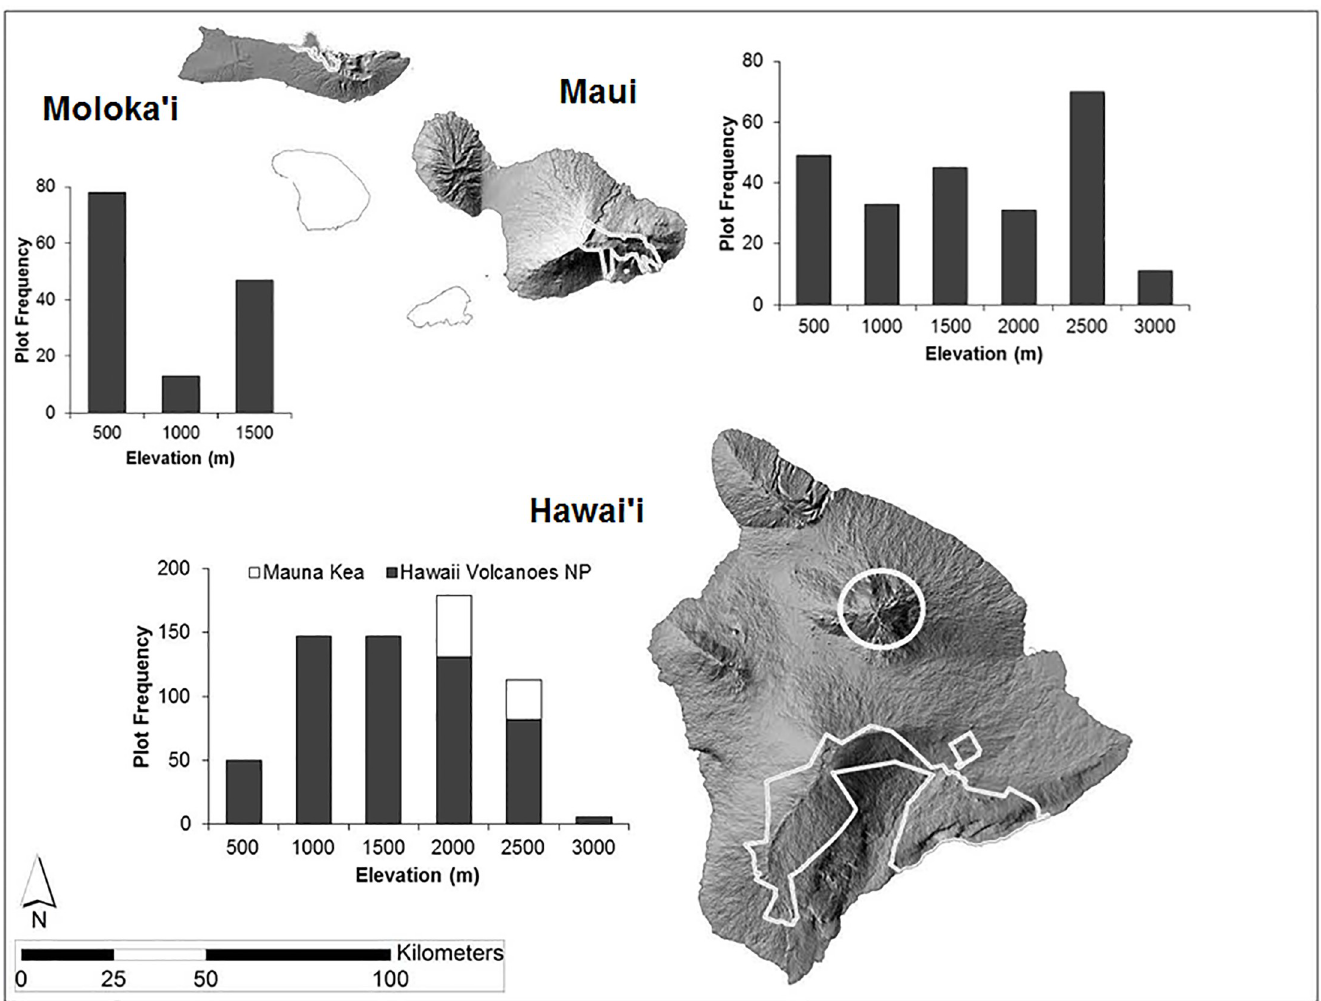
Fig 1. Hawaiian Islands on which plant species co-occurrence samples (1017 plots) were collected between 2004 and 2012. Plots range from sea level to 3000 meters within Hawai‘i Volcanoes National Park (563) and Mauna Kea state lands (79) on Hawai‘i, Haleakal ā National Park (239) on Maui, and Kalaupapa National Historical Park (138) on Moloka‘i. Plot frequency chart x-axis values indicate the upper end of each category (e.g., 1000 = plots located 501–1000 m).